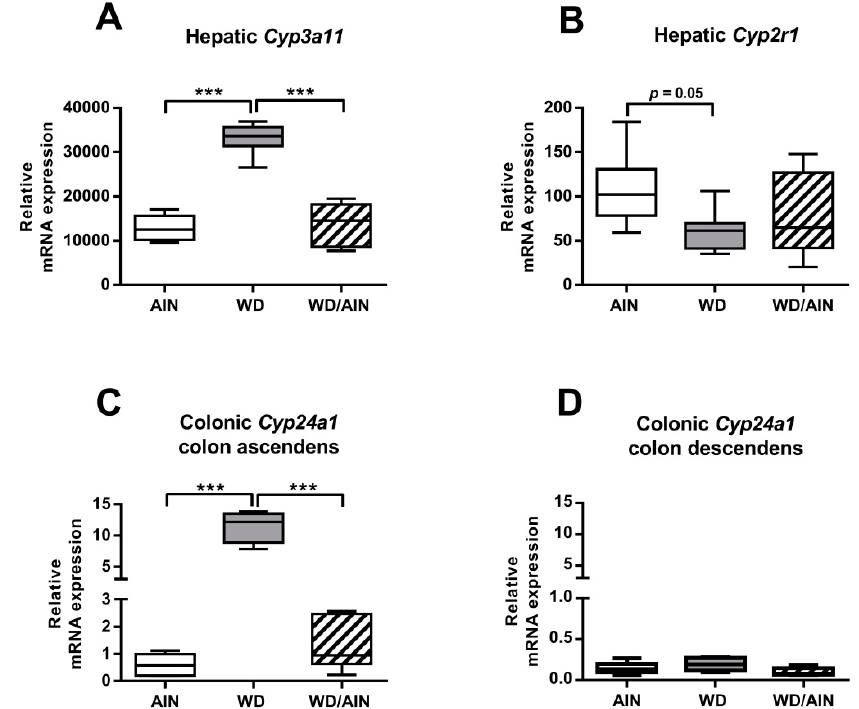
Figure 4. E ff ect of the diet on mRNA expression of the hepatic ( A ) Cyp3a11 , and ( B ) Cyp2r1 and on the colonic expression of Cyp24a1 in ( C ) the ascending and ( D ) descending colon ( n = 4–7). Median, Figure 4. Effect of the diet on mRNA expression of the hepatic (A) Cyp3a11 , and (B) Cyp2r1 and on interquartile range, and whiskers (minimum to max). In the WD group of ( A , C ) one outlier, as the colonic expression of Cyp24a1 in (C) the ascending and (D) descending colon ( n = 4–7). Median, determined by Grubbs’ test, was excluded from the analysis. ANOVA with Tukey post-hoc test; interquartile range, and whiskers (minimum to max). In the WD group of (A, C) one outlier, as *** p < determined by Grubbs` test, was excluded from the analysis. ANOVA with Tukey post-hoc test; * p < 0.05, *** p < 0.001.